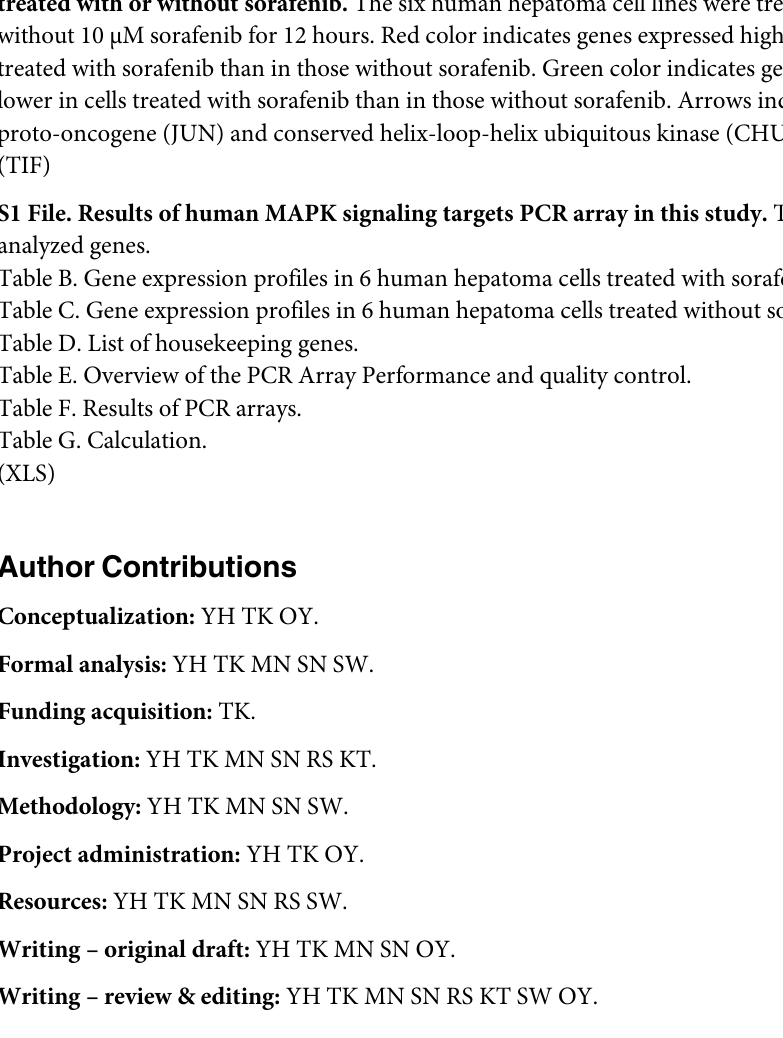
S1 Fig. Heat map analysis for the expression of MAPK-signaling pathway-associated genes in 6 human hepatoma cells (PLC/PRF/5, HepG2.2.15, Huh6, Hep3B, HepG2 and Huh7) treated with or without sorafenib. The six human hepatoma cell lines were treated with or without 10 μM sorafenib for 12 hours. Red color indicates genes expressed higher in cells treated with sorafenib than in those without sorafenib. Green color indicates genes expressed lower in cells treated with sorafenib than in those without sorafenib. Arrows indicate Jun proto-oncogene (JUN) and conserved helix-loop-helix ubiquitous kinase (CHUK).